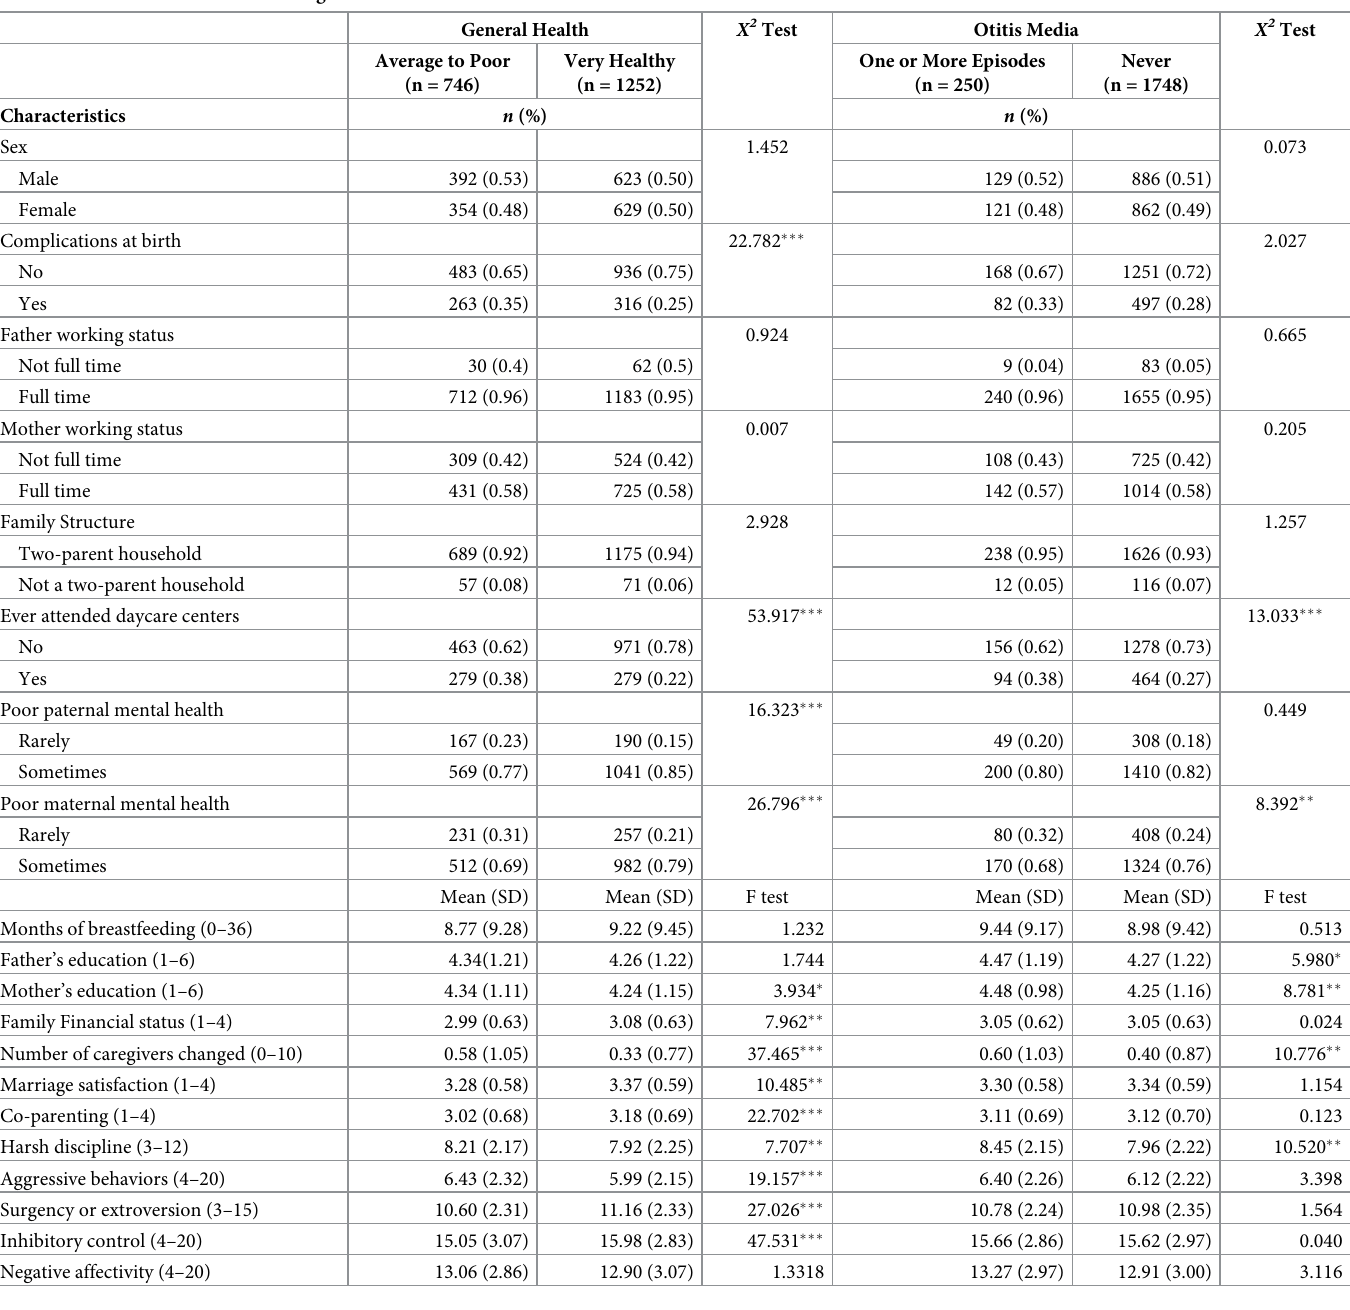
Table 2. Factors associated with child general health and otitis